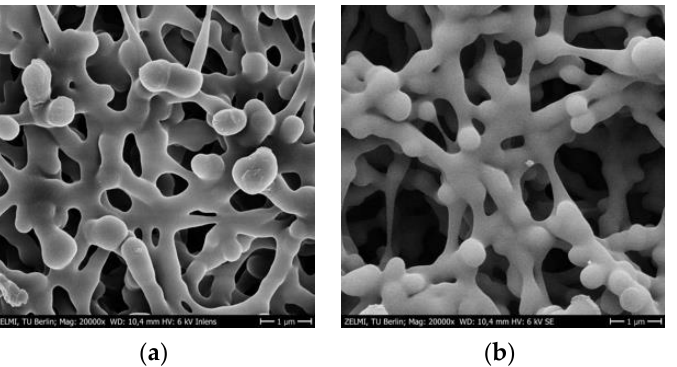
Figure 7. SEM micrographs of bare PES membranes recorded with ( a ) the InLens detector and ( b ) the secondary electron detector (SE).